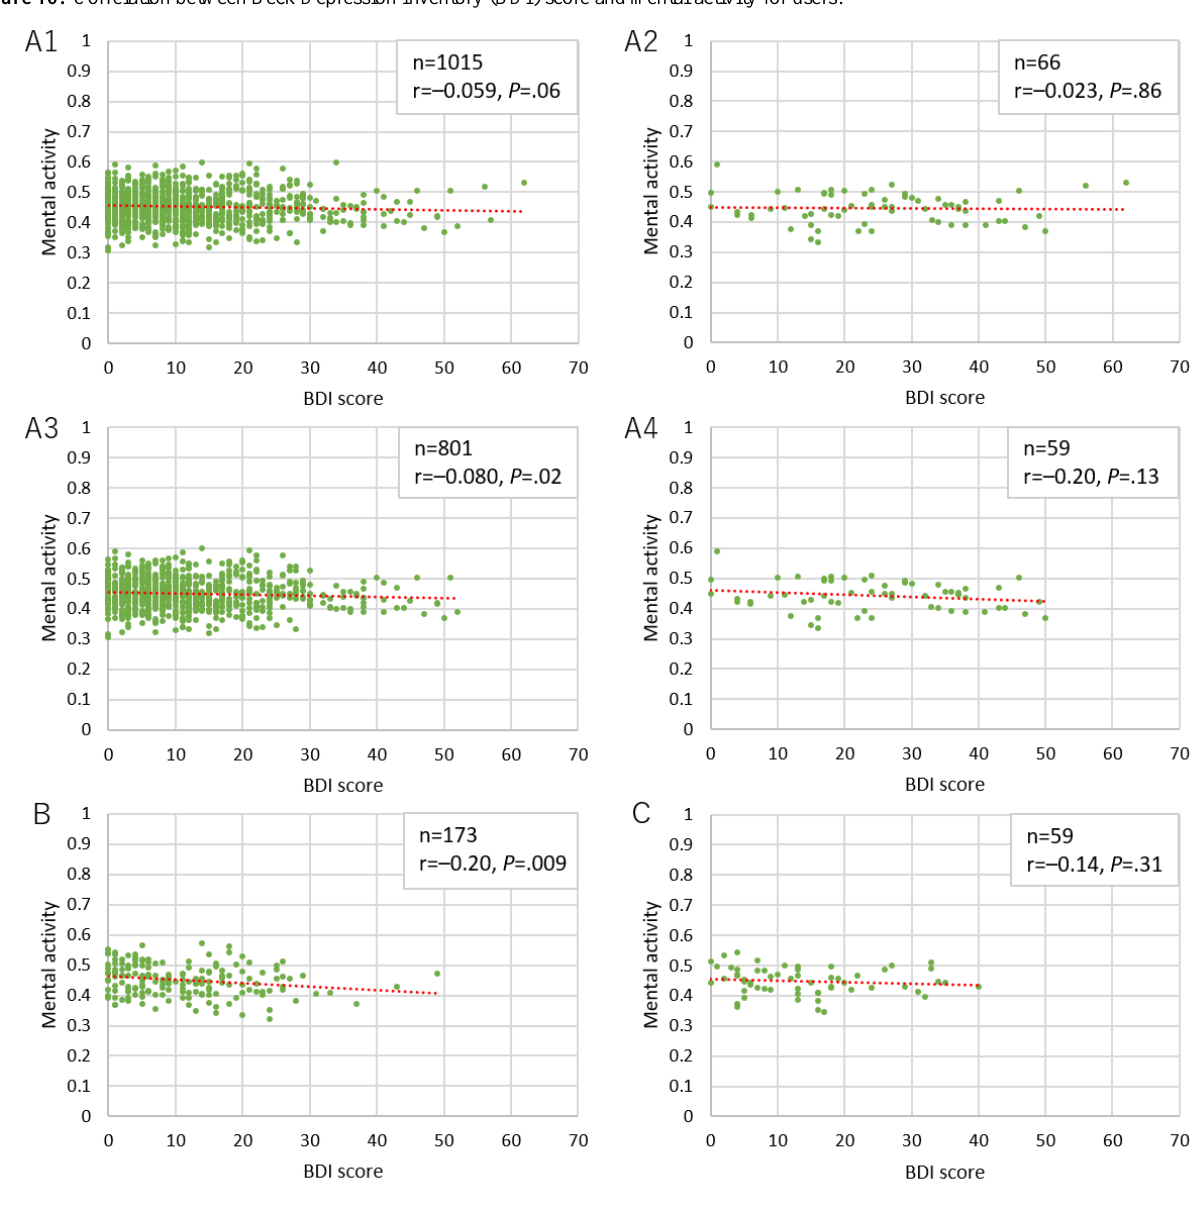
Figure 10. Correlation between Beck Depression Inventory (BDI) score and mental activity for